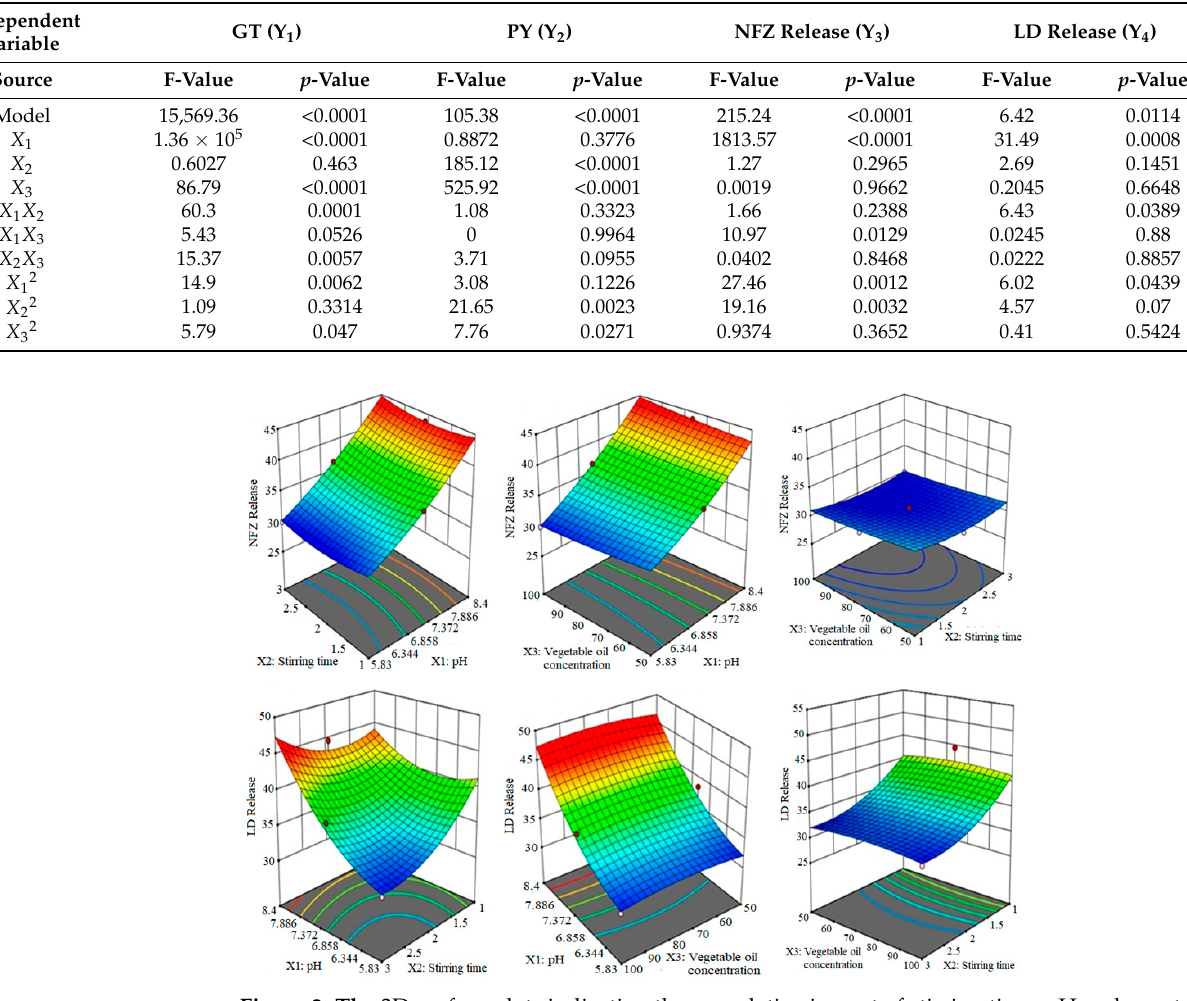
Figure 2. The 3D surface plots indicating the cumulative impact of stirring time, pH and vegetable oil concentration on the in vitro release of NFZ and LD. oil concentration on the in vitro release of NFZ and